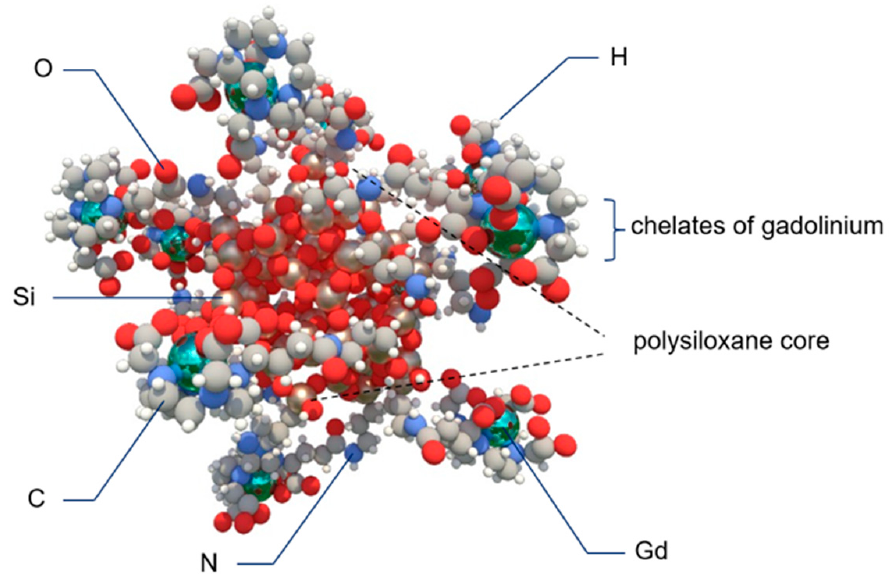
Figure 4. Schematic representation of AGuIX (Gd 10 Si 40 C 200 N 50 .O 150 H x ; size: <5 nm). Polysiloxane core is built of atoms of silica (Si; grey), oxygen (O; red), hydrogen (H; white); carbon (C, grey), nitrogen (N; blue) and surrounded by covalently grafted chelates of gadolinium (Gd; green). Modified from: Verry C. et al. 2019 (BMJ Open. 2019; 9(2):e023591).